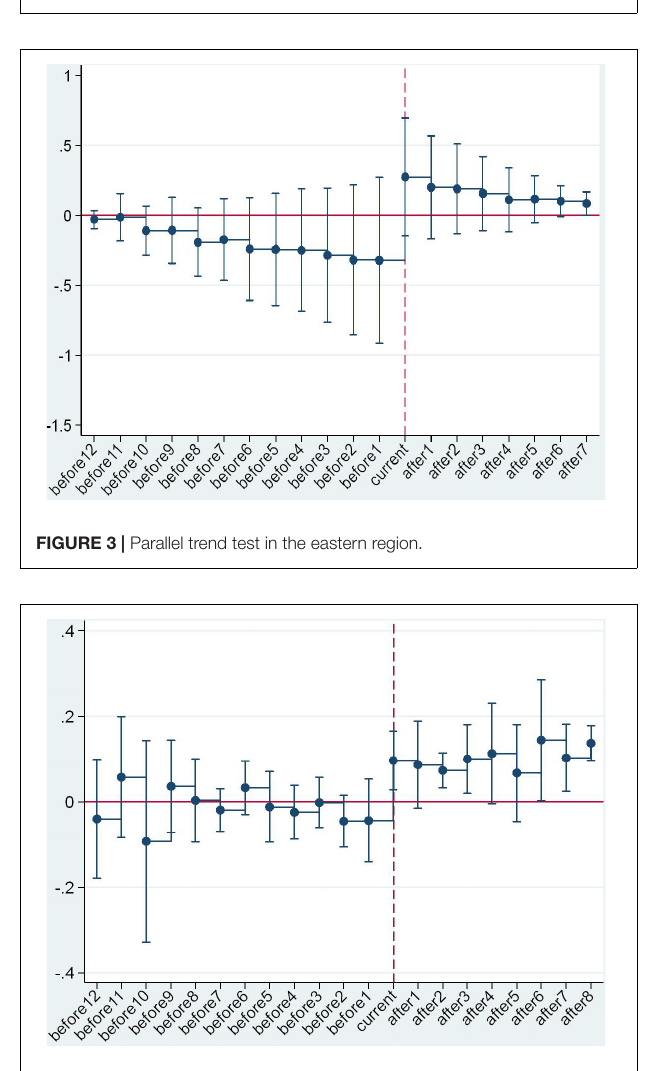
FIGURE 2 | Overall parallel trend test.